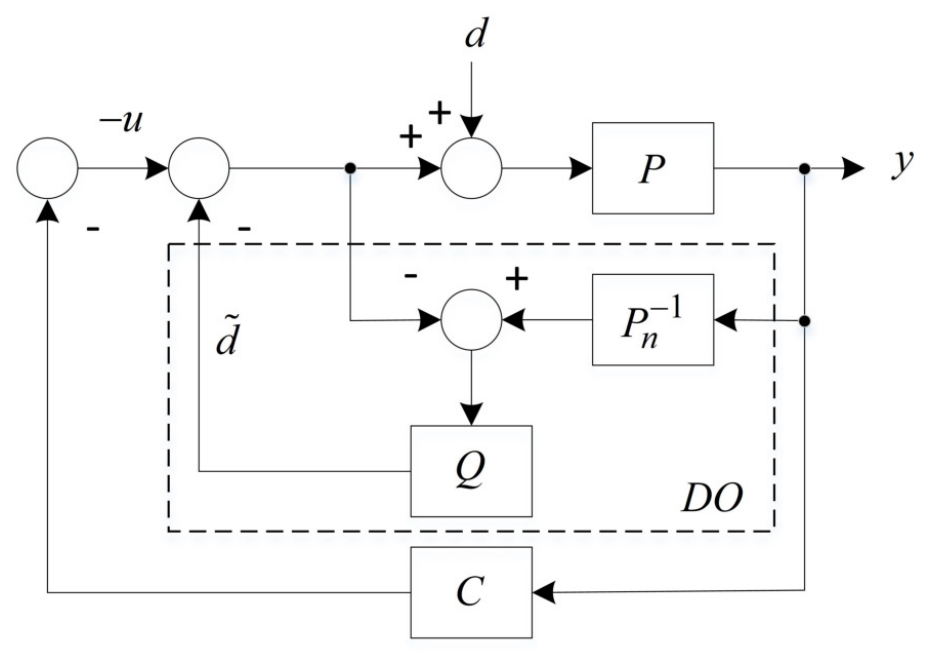
Figure 1. Conventional